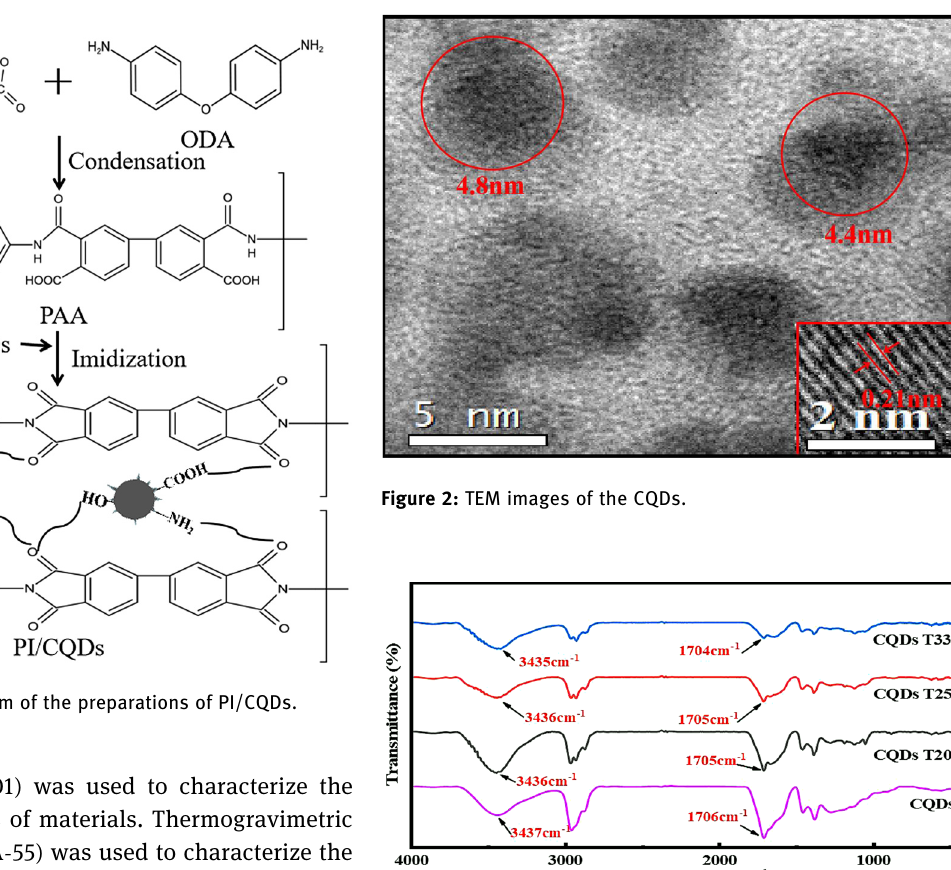
Figure 3: FT - IR image of CQDs.